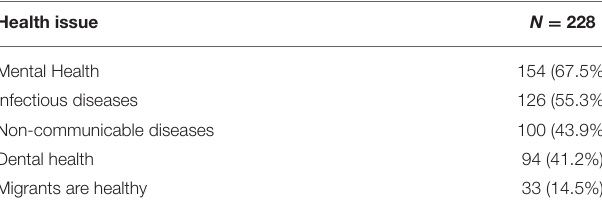
TABLE 2 | Professionals’ responses to the question, “In your opinion, what type of diseases is more frequent in migrants, refugees, and asylum seekers?